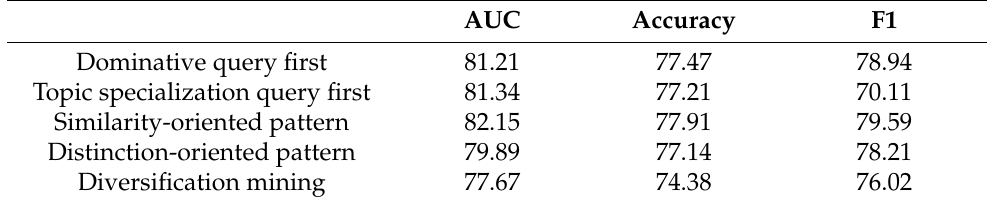
Table 5. Performance of QCB sessions’